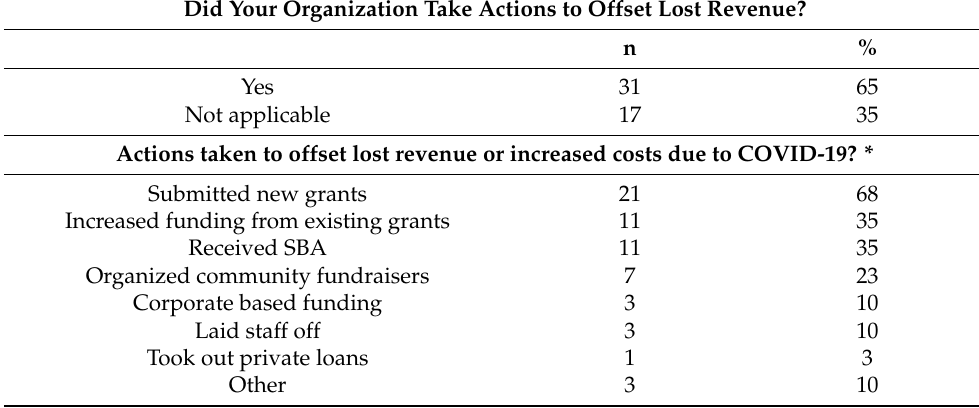
Table 8. Actions Taken to Offset Lost Revenue.